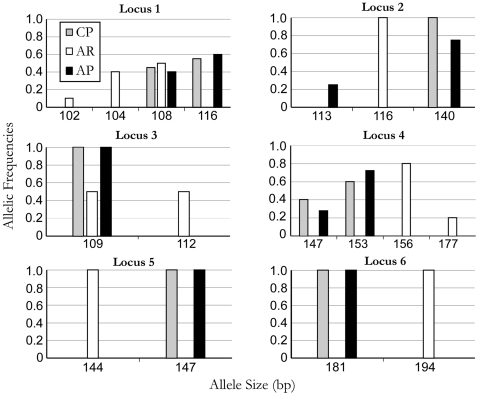
Microsatellite allelic frequencies.Panels represent the allelic frequencies of the six microsatellite loci (Loci 1-6), which are examined for each mosquito strain (AP, AR and CP). In each panel, the Y-axis denotes allelic frequencies and the x-axis denotes the size of each fragment in base pairs. Loci 1-6 correspond to previously reported microsatellite loci AP1-AP6 [17] (naming modified here to avoid ambiguity with mosquito strains).